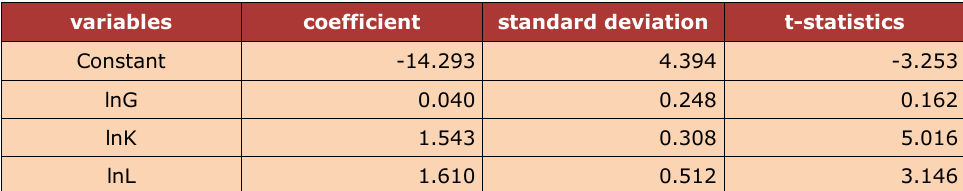
Table 2. Estimated coefficient of the state-owned transportation and storage industry